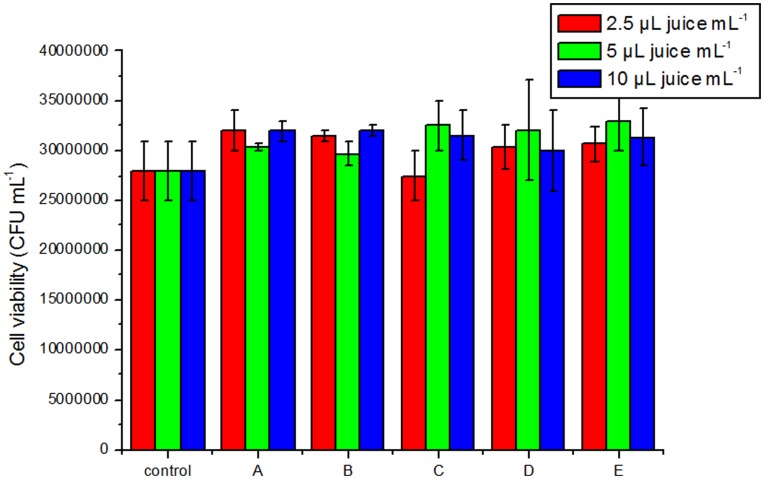
Cell viability of yeast S. cerevisiae exposed to different concentrations of juices fo 2 h.A – chockeberry, B – blackcurrant, C – blueberry, D – bilberry, E – elderberry. Data are expressed as means of CFU/mL ±SE.